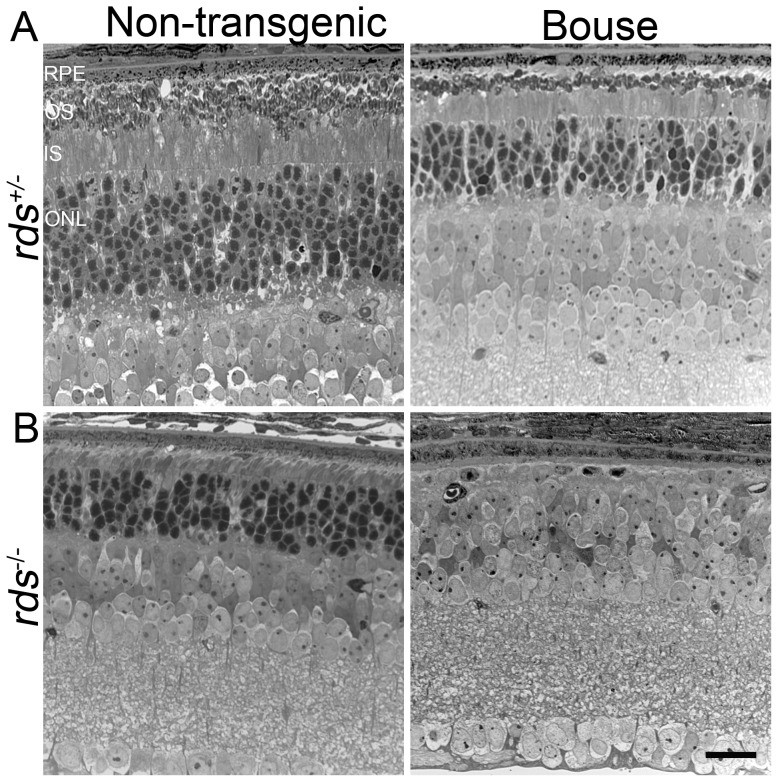
Overexpression of rhodopsin accelerates RDS-associated degeneration.Representative light micrographs were captured from plastic embedded retinal sections harvested at P30 from non-transgenic or Bouse transgenic mice in the rds
+/− (A) or rds
−/− (B) backgrounds. Scale bar 20 µm. RPE: retinal pigment epithelium, OS: outer segment, ISL: inner segment, ONL: outer nuclear layer.